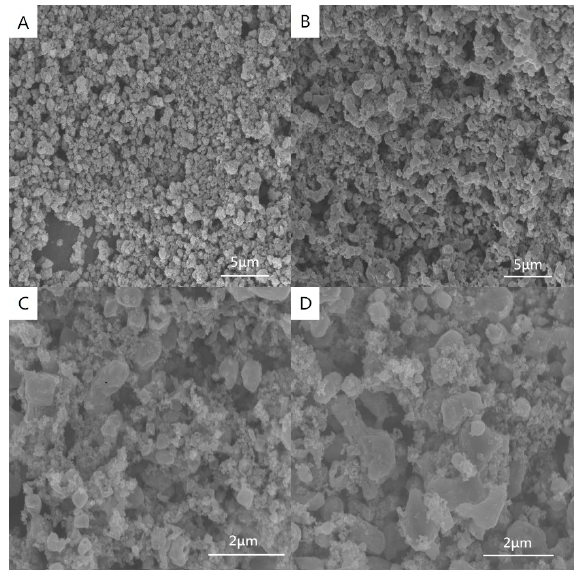
Figure 3. XRD patterns of the samples synthesized at ( A ) 1300 °C and ( B ) 1400 °C.